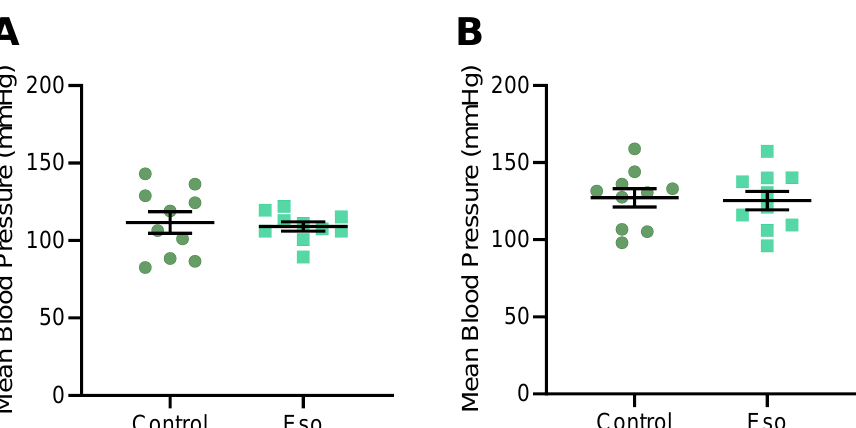
Figure 6. Mean arterial blood pressure of obese mice receiving L-NAME with esomeprazole treatment at ( A ) D14.5 and ( B ) D17.5 of pregnancy. Blood pressure was measured via tail cuff plethysmography. Mean arterial blood pressure was not significantly altered between the obese mice receiving L-NAME, treated with esomeprazole, and the vehicle control treated mice. Results presented as mean ± SEM; n = 10 mice/group.